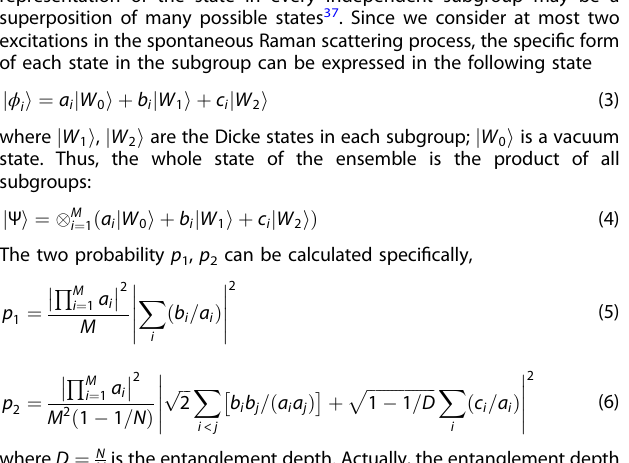
Fig. 5 The time sequence of pulses used for generating and verifying entanglement. The whole time sequence for initializing, generating, and verifying process. The initializing pump light used for preparing the initial state of atoms is in the transition from 6 S 1 = 2 ; F ¼ 4 (cid:4) (cid:5) (cid:4) 6 S 3 = 2 ; F ¼ 4 , and the 2 ns pulses for exciting and verifying the entanglement are applied when the pump light is off. The relative time information for the Stokes and anti-Stokes photons, created in the generating and verifying process, are recorded by the counting module of single photon detection. We have chosen six different delays to verify the evolutions of the W state from 30 – 1200 ns. For brevity, we have omitted the graphs of 120, 300, and 900 ns. The preparing time for the initial state in each trial is 700 ns, and the repeating period for each trial is 2.1